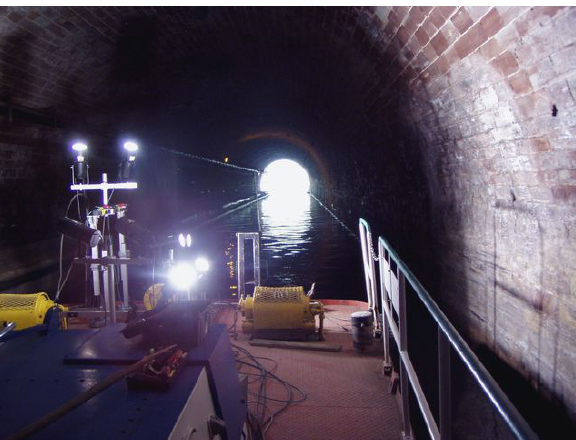
Figure 7: Modular imaging prototype onboard a barge in the ex- perimental tunnel.